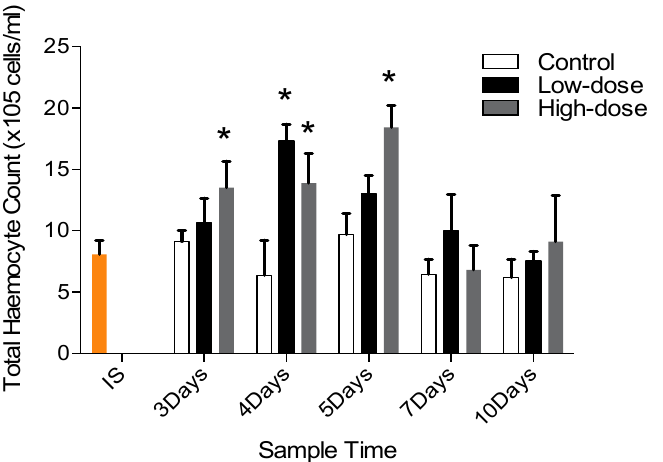
Figure 10. Total haemocyte count (THC) of the control and sulphated galactans treated P. serratus . The mean THC of the initial sample group (IS) is shown.* indicates statistical significant difference to the